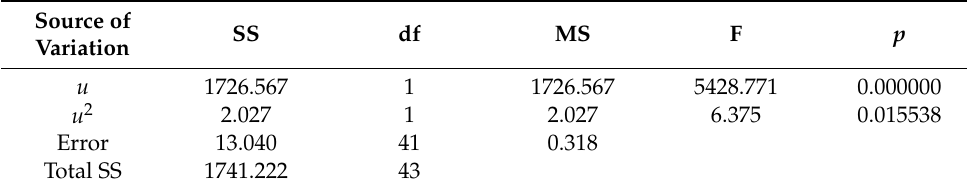
Table 13. Model of tensile strength — ANOVA table, R 2 = 0.99; R adj2 = 0.99.